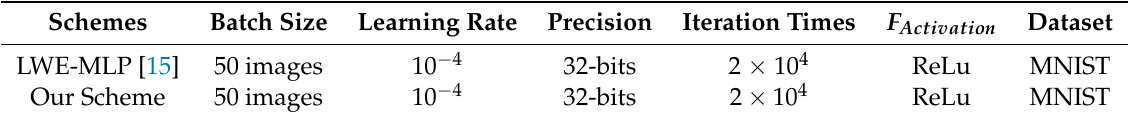
Table 3. Experimental settings in model training.